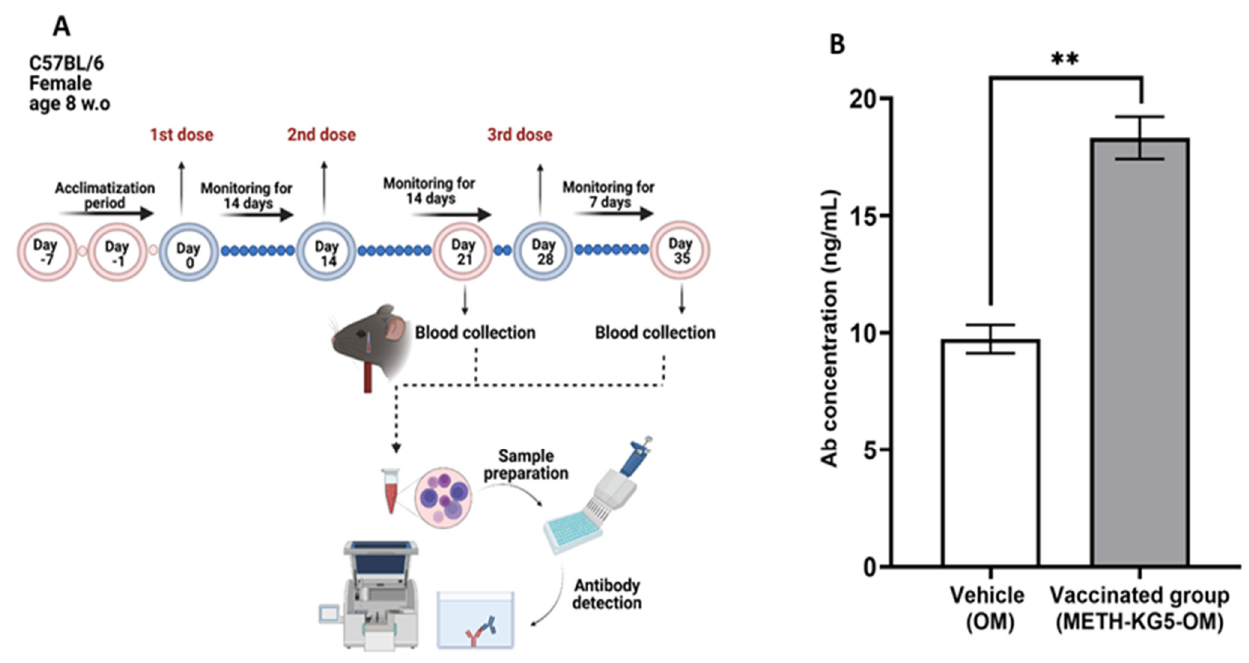
Figure 9. ( A ) Animal study timeline and ( B ) antibody titer by ELISA. ** p < 0.01; bars represent mean + standard error of the mean (SEM). + standard error of the mean